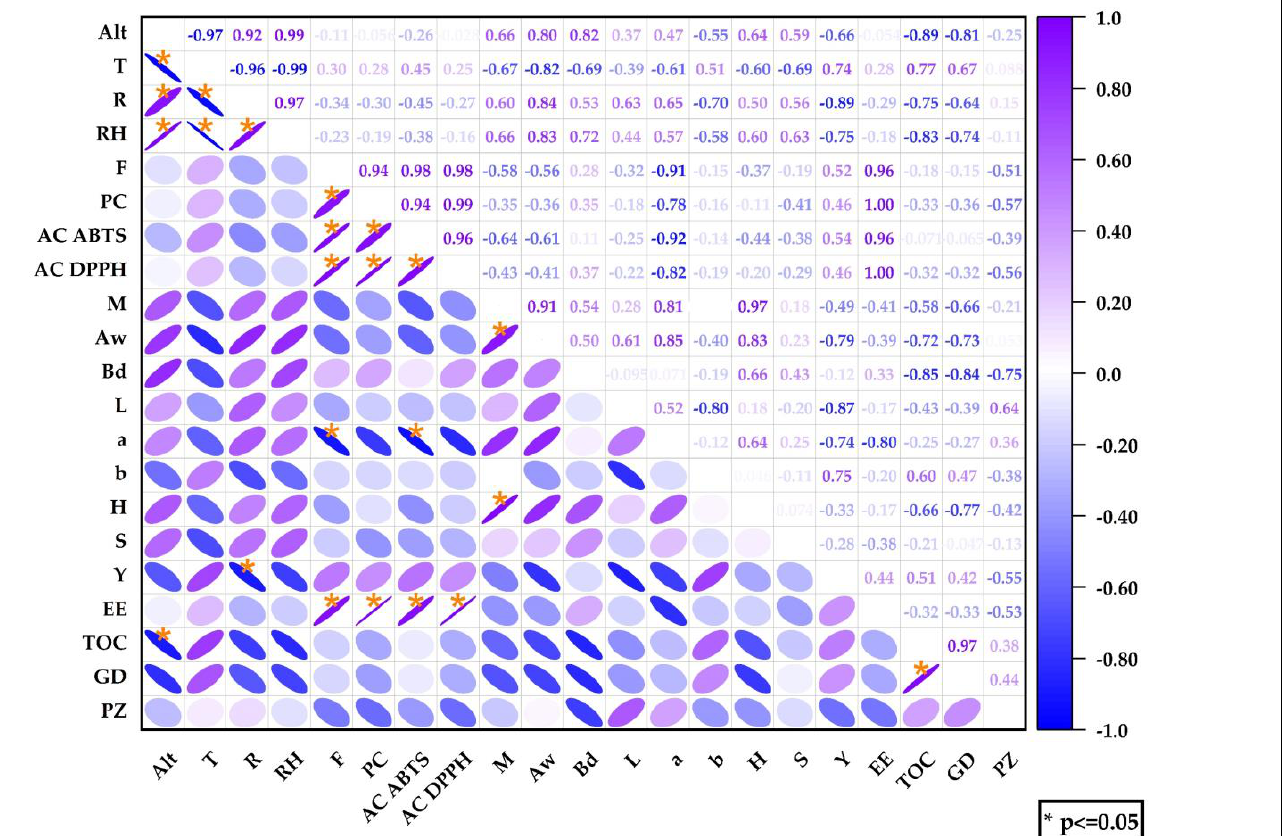
Figure 13. Heat map of climatic conditions and properties studied.